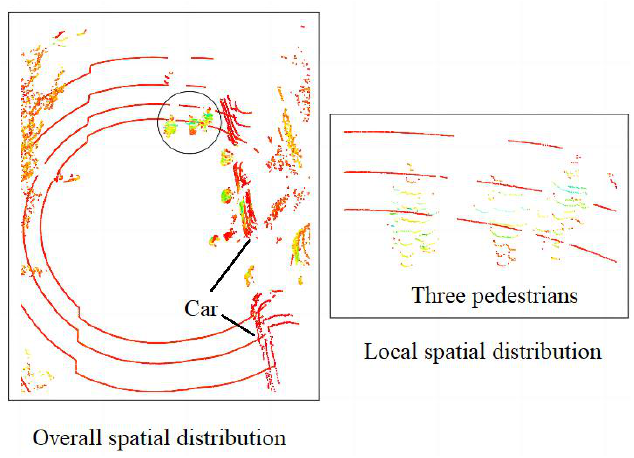
Figure 4. Point cloud spatial